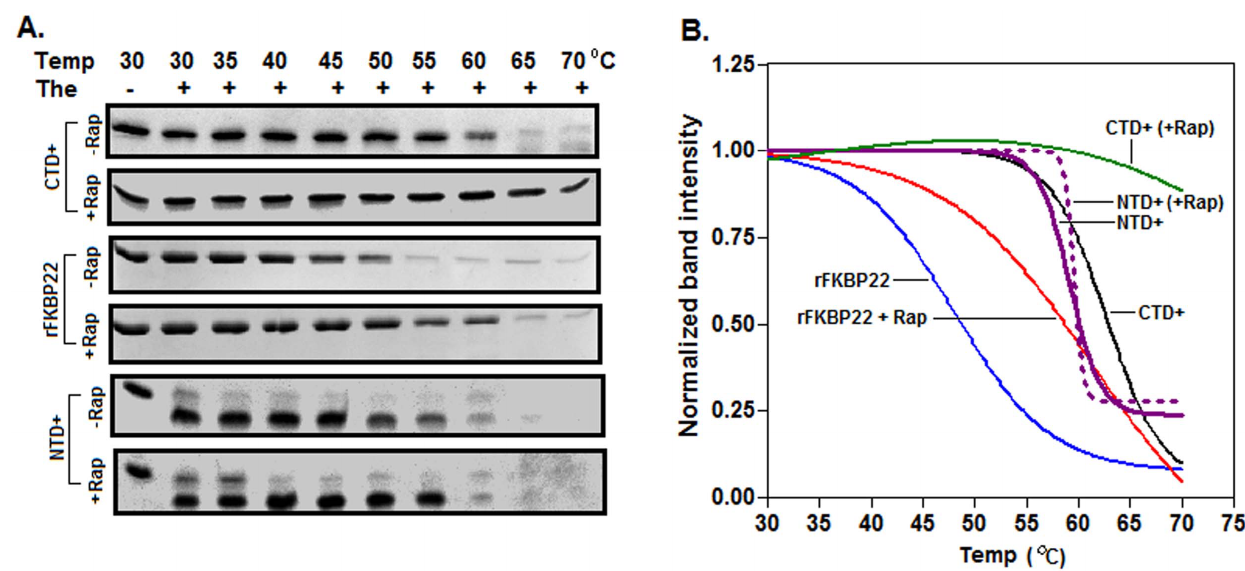
Figure 4. Limited proteolysis of the proteins with thermolysin at 30 6 –70 6 C. (A) SDS-13.5% PAGE analyses of the indicated proteins digested with thermolysin (The). (B) The intensities of the protein (undigested) bands were determined (by scanning the gel pictures in Panel A with a Gel Doc system), normalized with respect to that of the same at 30 u C, and plotted versus the corresponding temperatures.